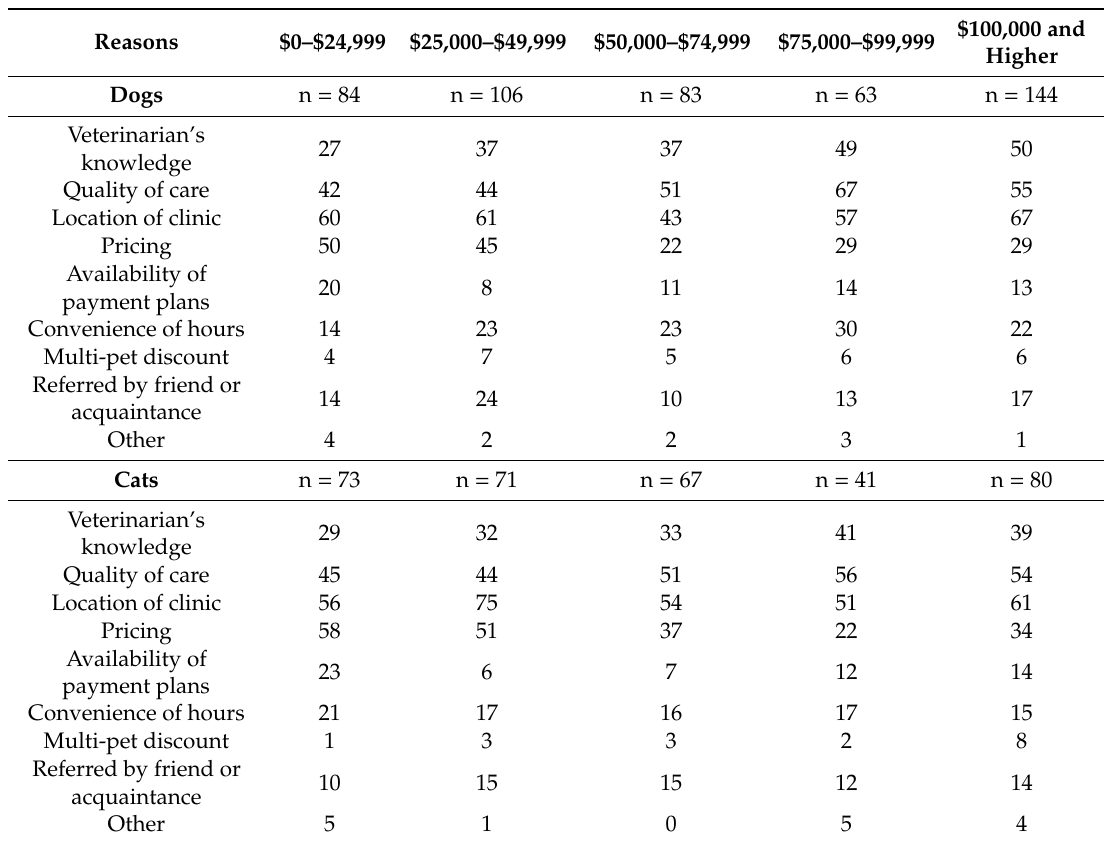
Table A3. Reasons for selecting regular veterinarian /